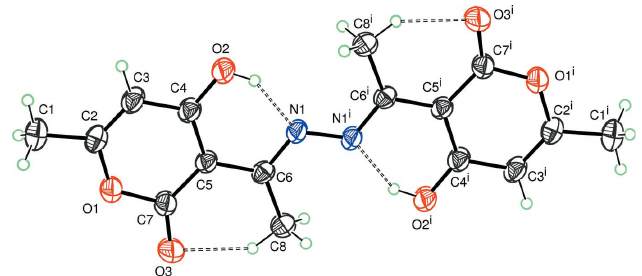
Figure 1 The title molecule with the atom-labelling scheme. The intramolecular hydrogen bonds are represented by dashed lines. Displacement ellipsoids are drawn at the 50% probability